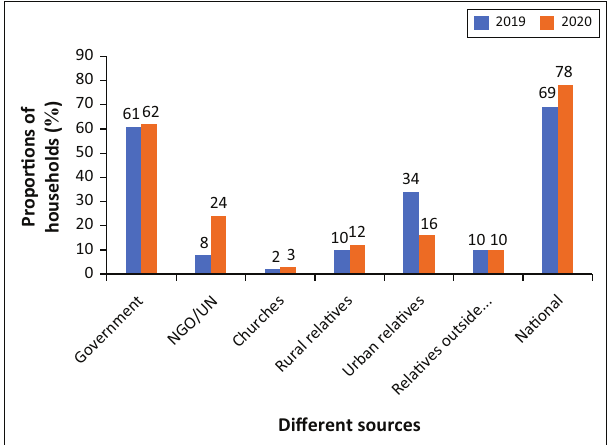
FIGURE 7: Maize grain prices in five major cities for the months July to October